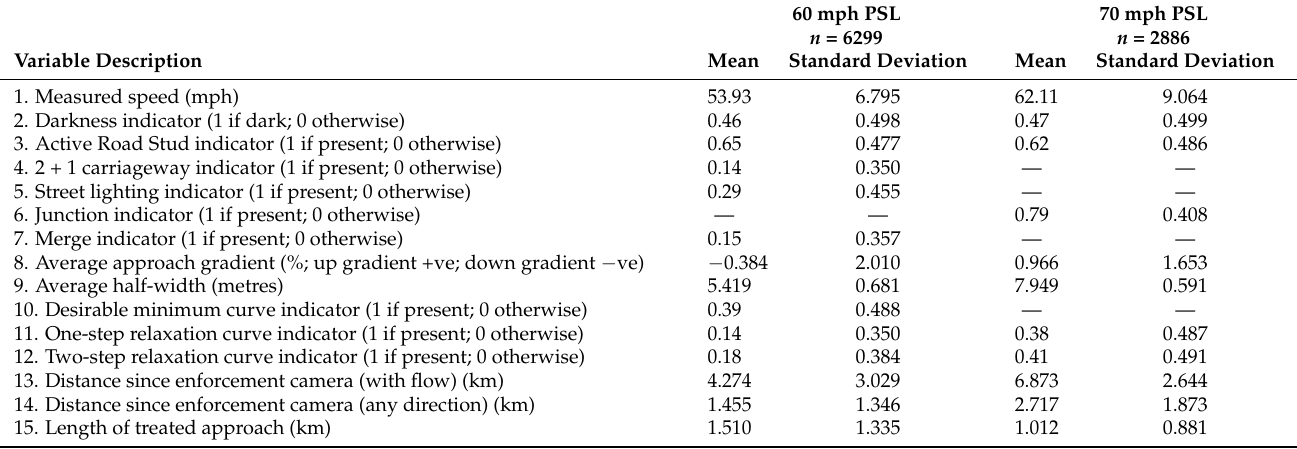
Table 6. Variable descriptive